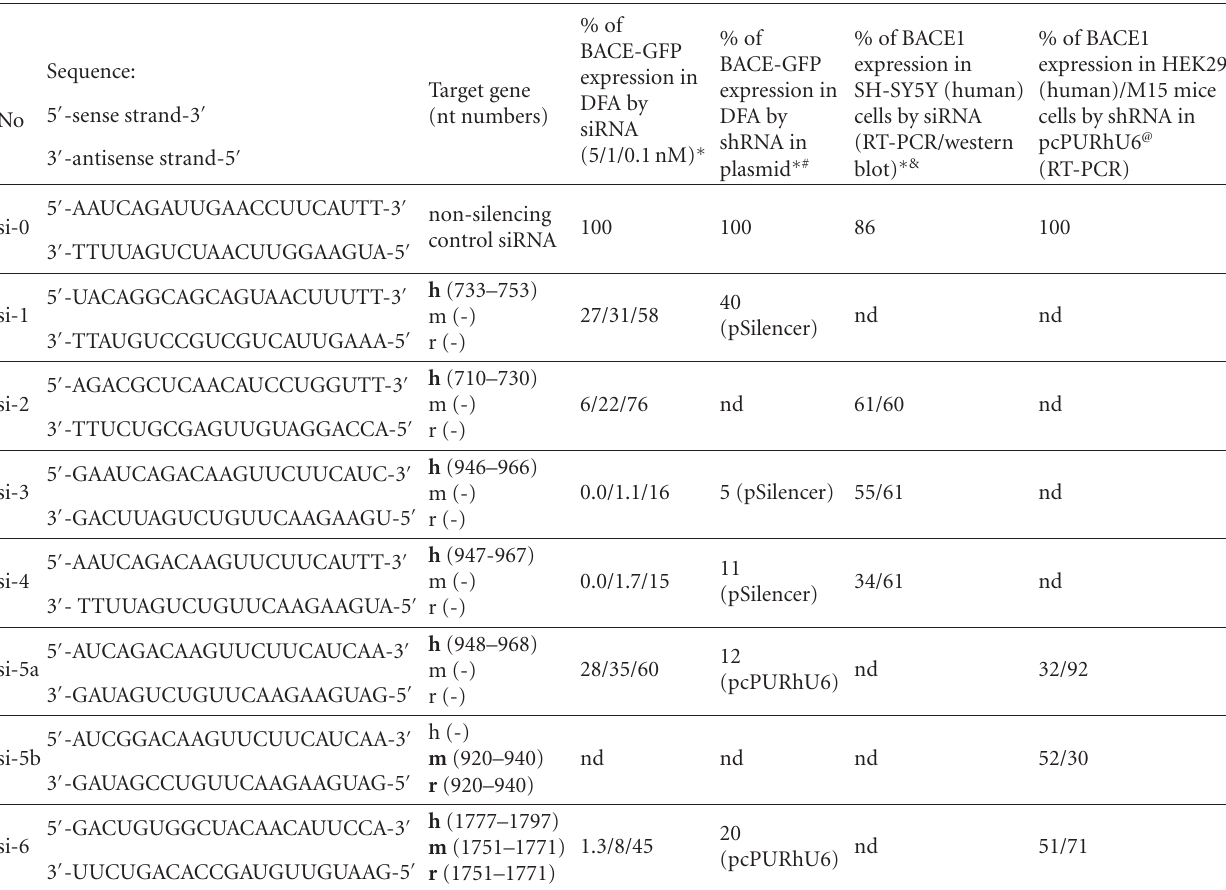
Table 1: SiRNA sequences, target sites in human, mouse, and rat mRNA of BACE1 and silencing activity of used siRNA- and shRNA-coded plasmids (presented as % of BACE1 gene